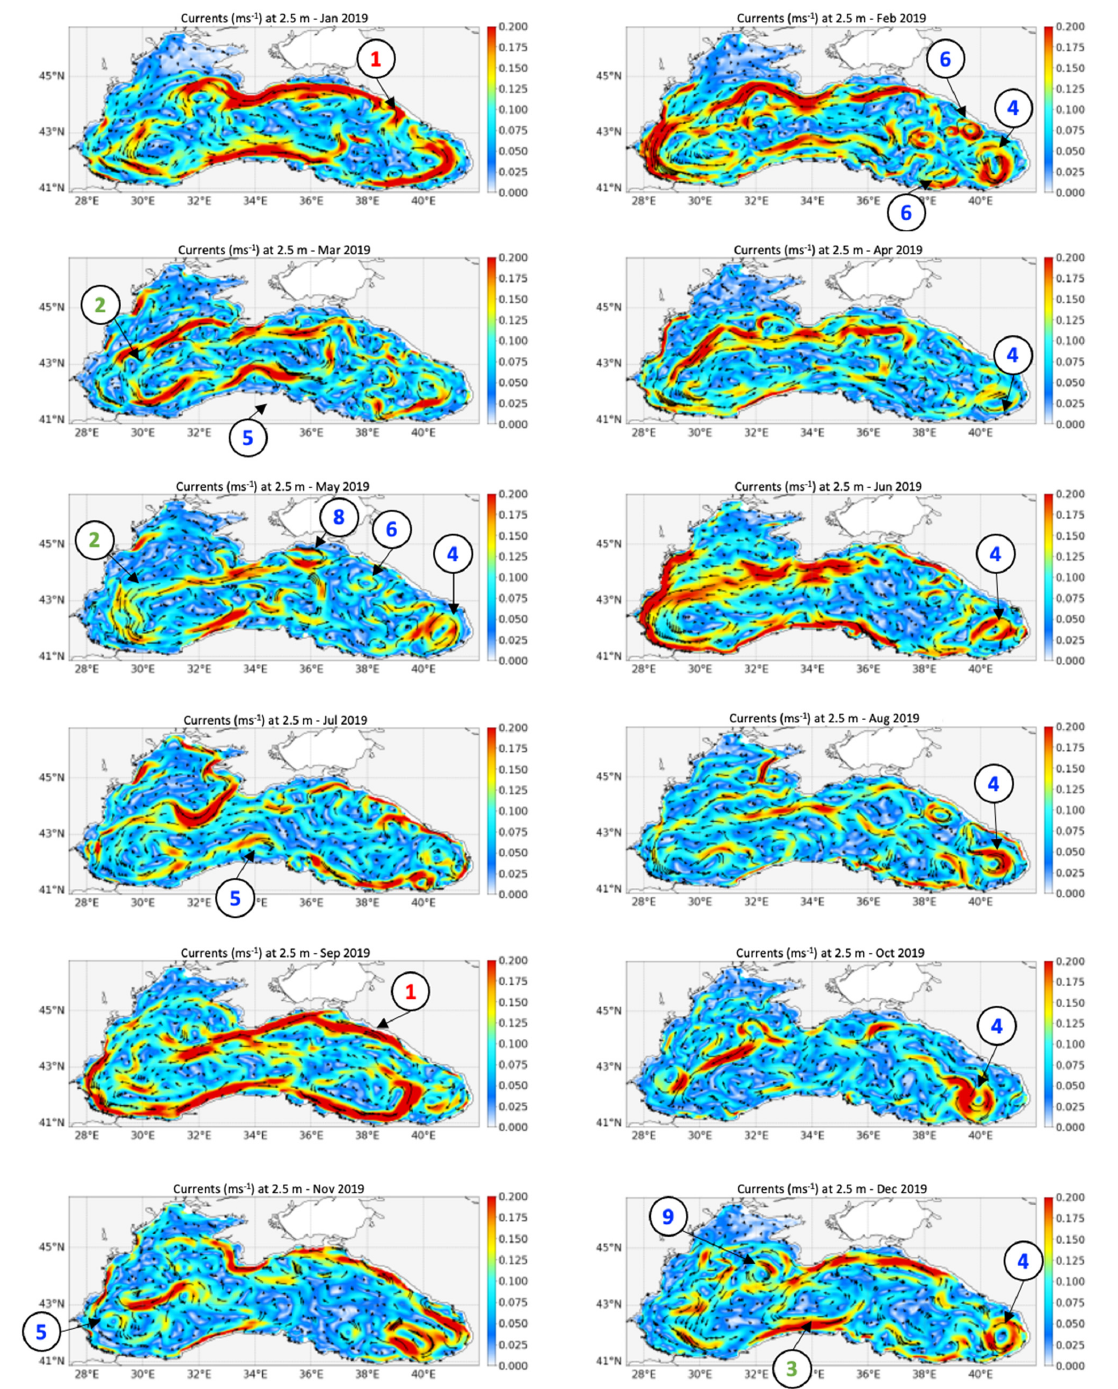
Figure 10. Surface currents in 2019: monthly means from Jan to Dec 2019. The reference month and depth are written on the top of each panel. Main structures: (1) Rim Current, (2) Western Gyre, (3) Central Gyre, (4) Batumi anticyclonic eddy, (5) anticyclonic coastal eddy, (6) Caucasus anticyclonic eddy, (7) cyclonic coastal eddy, (8) Kerch anticyclonic eddy, (9) Sevastopol anticyclonic eddy.